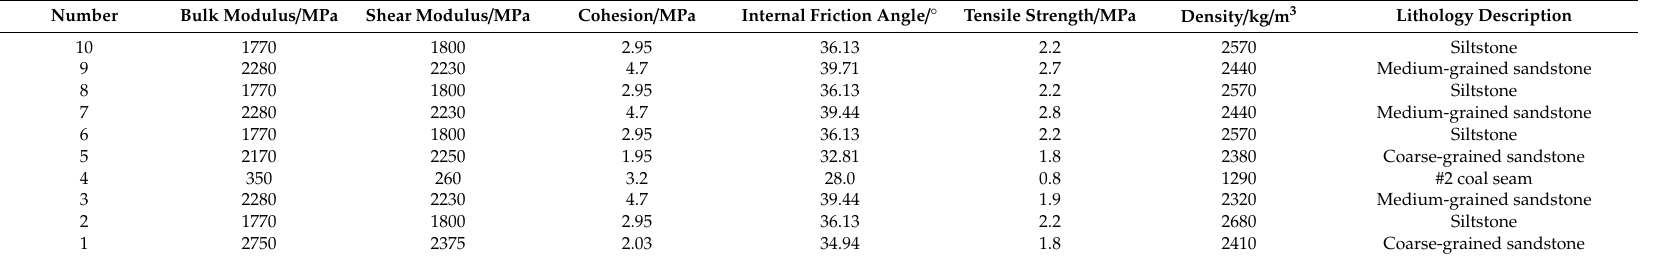
Table 1. Physical and mechanical parameters of rock mass of each formation in the simulation area.